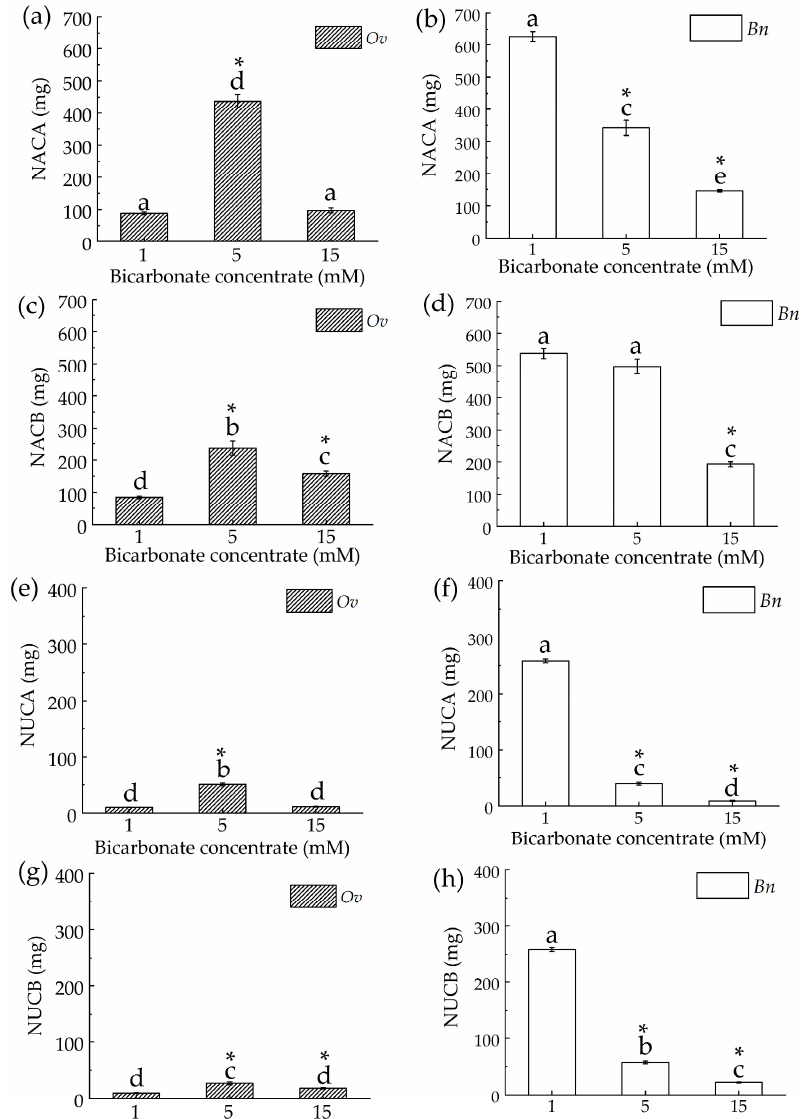
Figure 5. The contribution of nitrate/ammonium to NAC and NUC in Ov and Bn at different bicarbonate levels. Ov—Orychophragmus violaceus , Bn—Brassica napus . NACA—the contribution of ni-